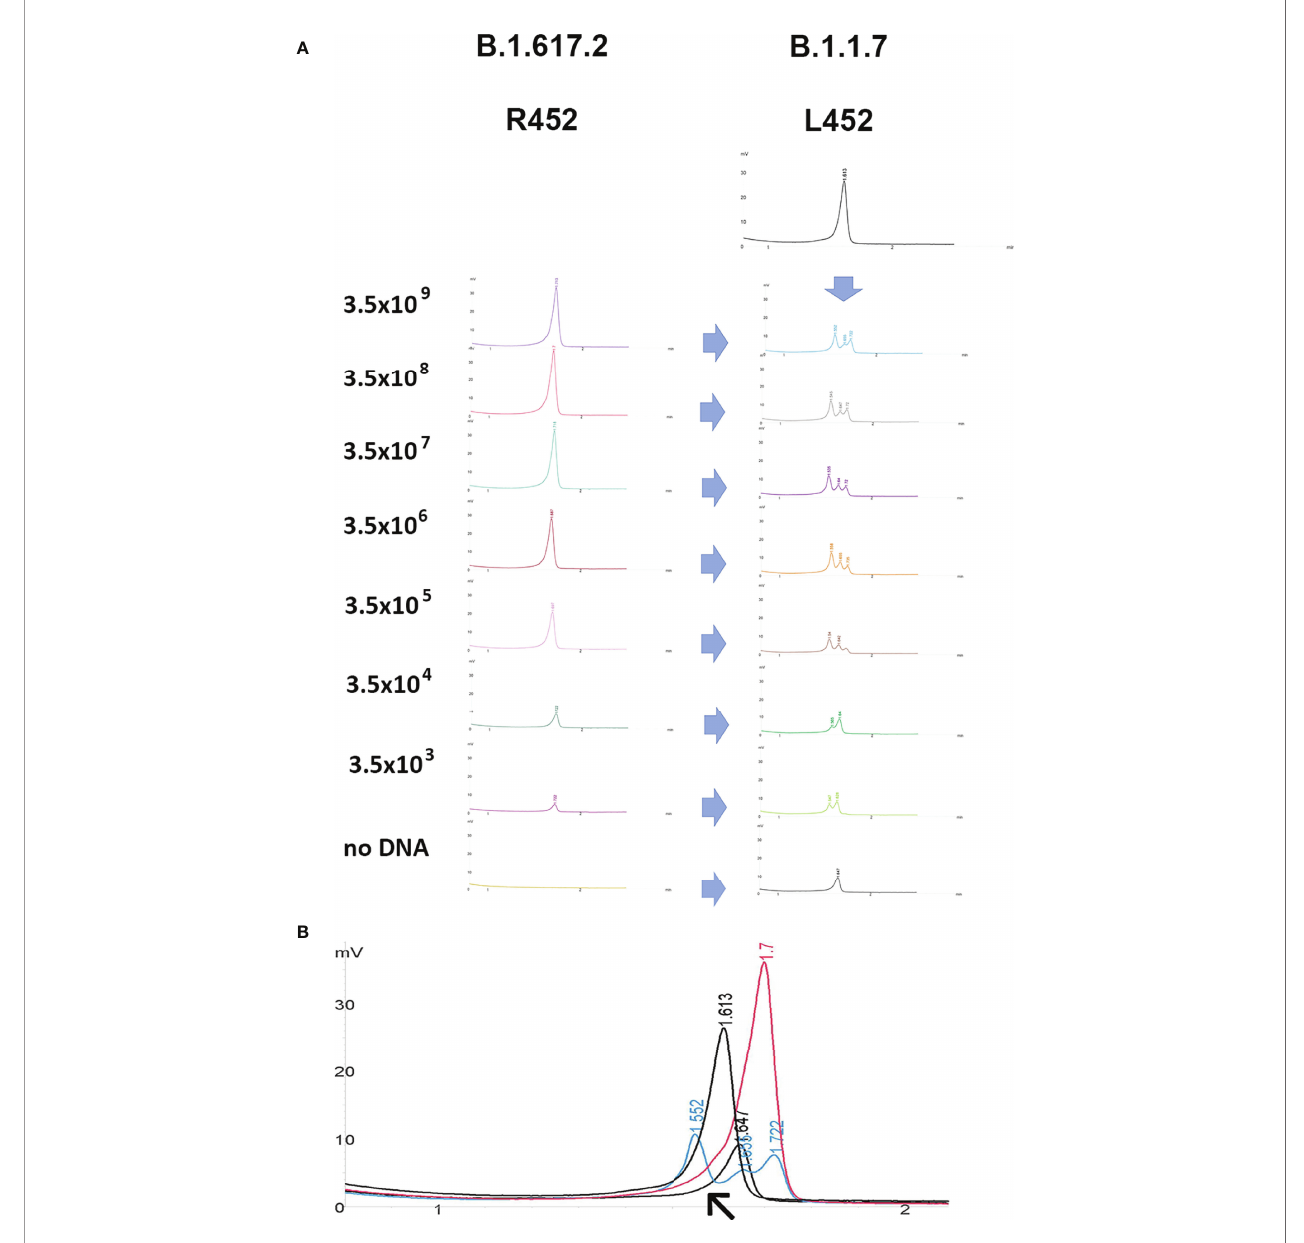
FIGURE 3 | Denaturing high-performance liquid chromatography. (A) dilutional experiment to verify the effect of unbalanced concentration of amplicons. Example of the RBD_1 target screened by mixing amplicons obtained from samples containing different viral loads expressed as copies/mL (B.1.617.2) with the reference sample (B.1.1.7). The (B.1.1.7 and B.1.617.2) variants present a L452R amino acid substitution. The mixed samples containing heteroduplexes can be readily identi fi ed at any viral load. (B) Higher magni fi cation of overlapping chromatograms of the reference sample (B.1.1.7; red curve) and the test (B.1.617.2; black curve) samples as such and mixed with each other to form heteroduplexes appearing as multiple peaks, modifying the chromatogram shape (cyan and grey curves). The no-DNA control mixed with the reference samples is also shown in the lower grey curve containing a single peak